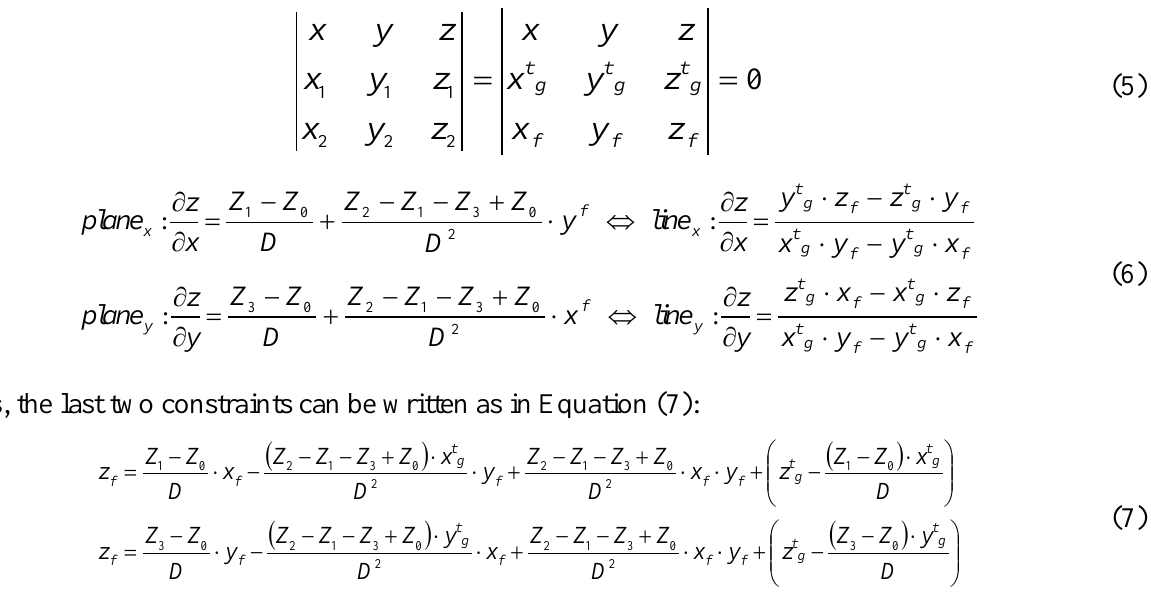
Figure 7. Schematic explanation of least squares target function minimization via three constraints: g t ( x , y , z ) depicts the transformed point from g and f ( x , y , z ) i counterpart point upholding the local plane grid-cell that is closest to g t ( x , y , z )